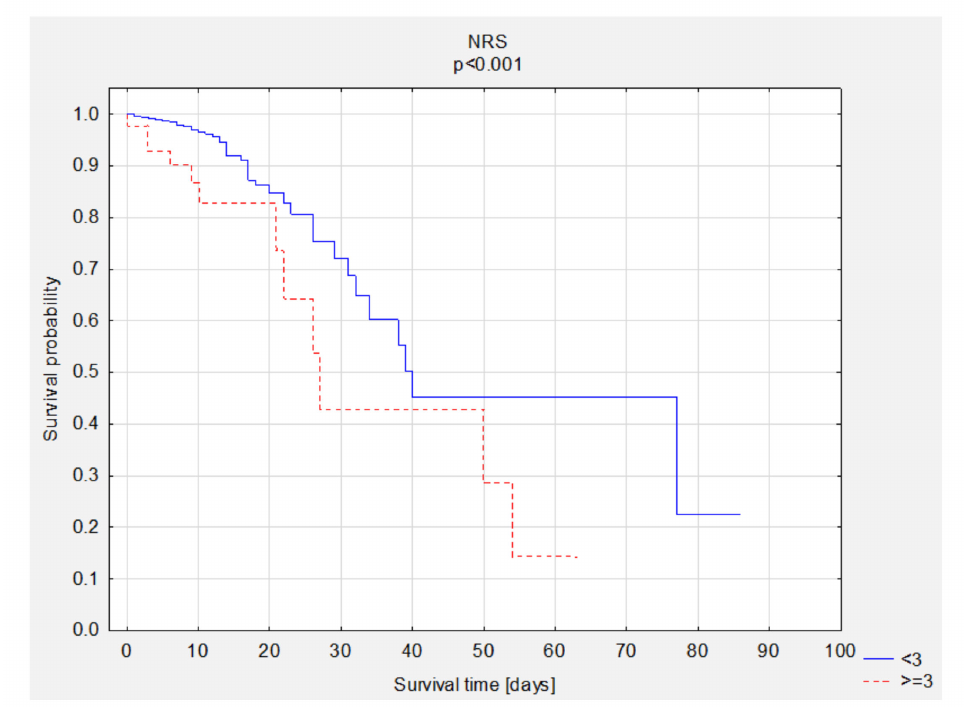
Figure 3. The comparison of survival curves according to NRS scores. Abbreviations: NRS, nutritional risk screening.